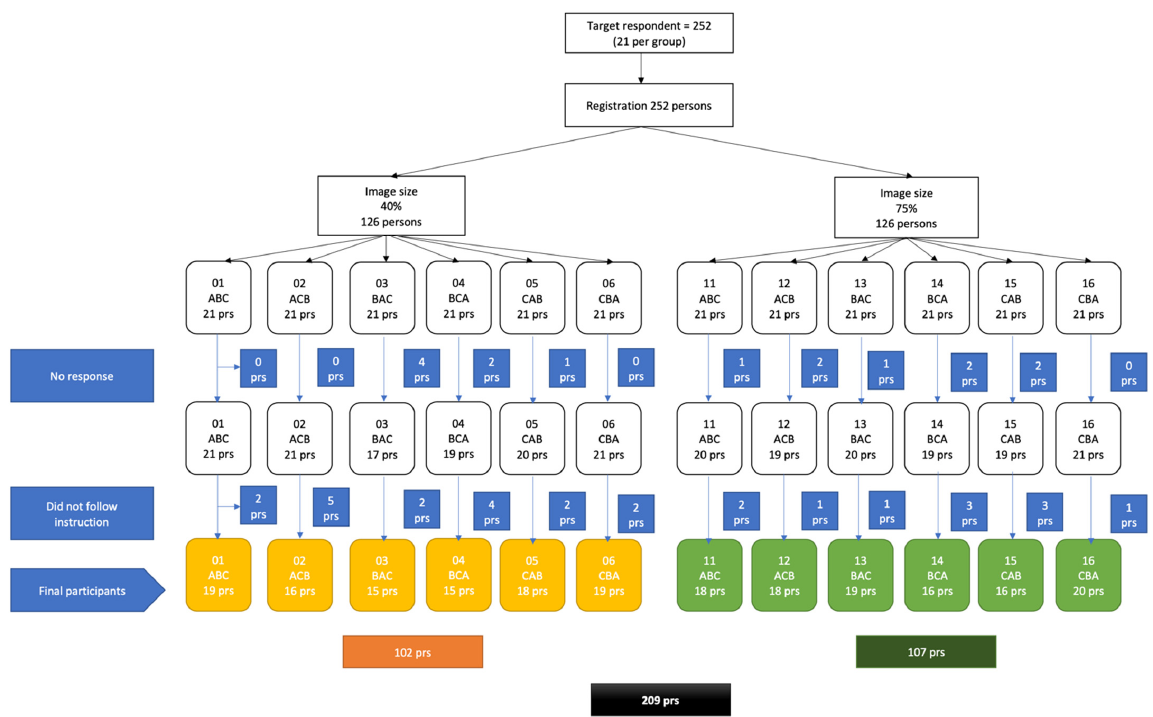
Figure 1. Assignment to condition and image counterbalancing. Note: A = Fear appeal image, B = Guilt appeal image, C = Financial loss appeal image. ABC, ACB, etc. show the order of images shown to each participant.